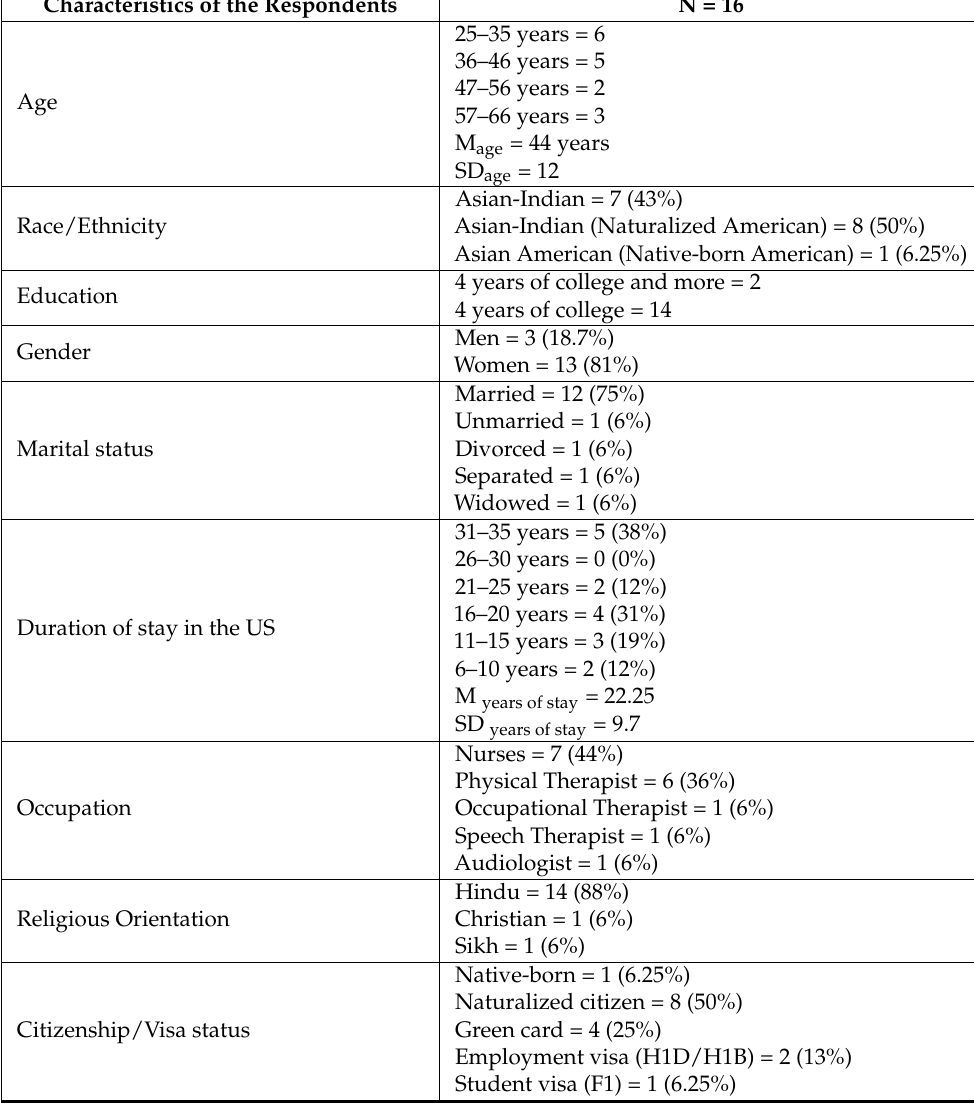
Table 1. Demographic Characteristics of the Healthcare